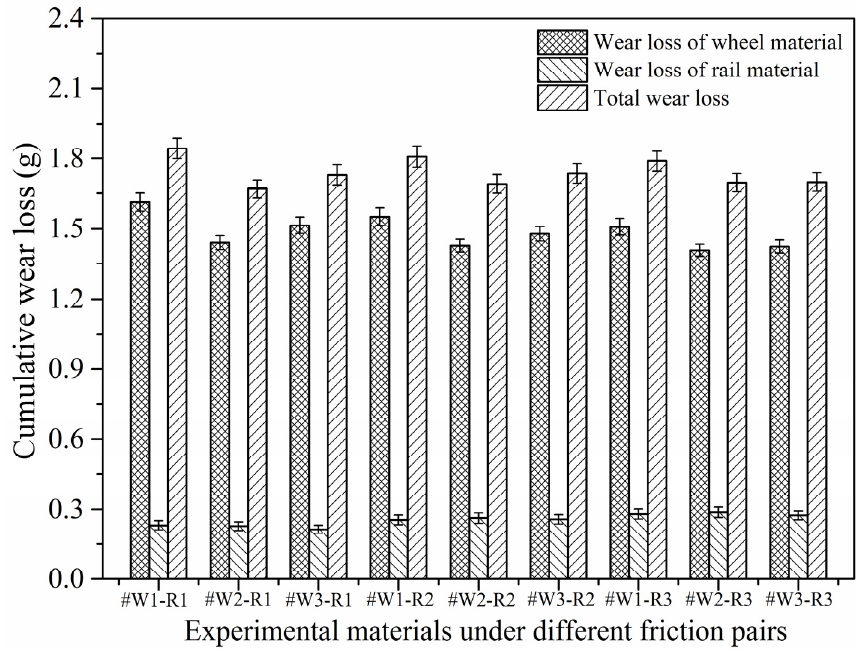
Figure 10. Cumulative wear loss of the wheel / rail discs after the rolling-sliding contact.